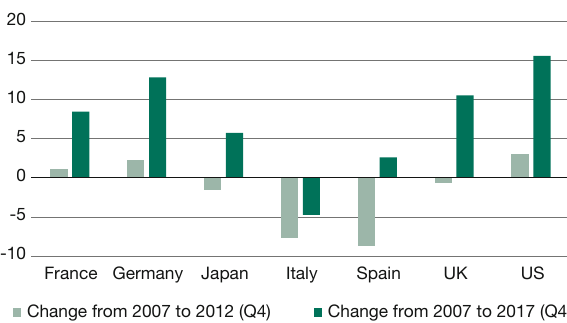
Source: Charting the Financial Crisis: US Strategy and Outcomes, joint report by Hutchins Center on Fiscal and Monetary Policy at Brookings and Yale School of Management Program on Financial Stability.